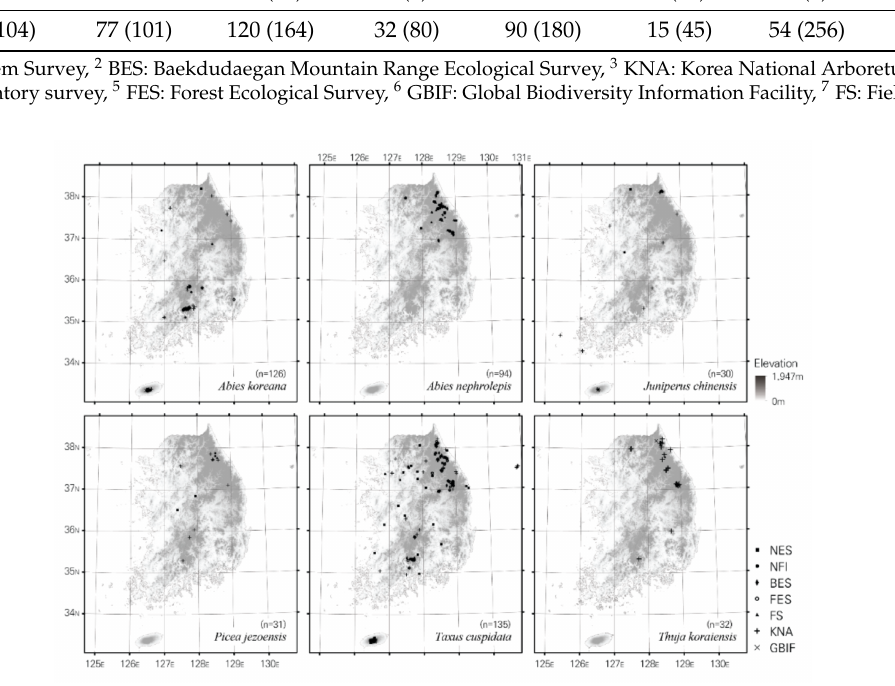
Figure 1. Occurrence sites of six subalpine forest species in South